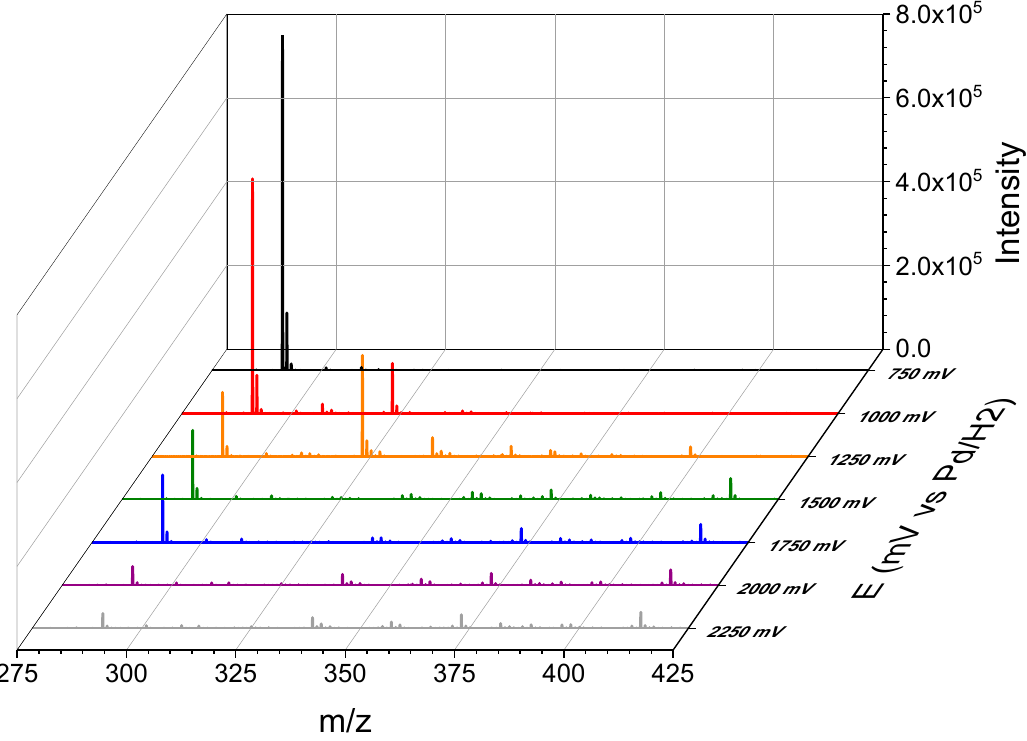
Figure 5. Mass spectrometry voltammogram of TRI obtained with the thin-layer flow cell coupled online with the QqTOFMS. The solution was composed of 0.1% FA in ACN:H 2 O 1:1 and the concentration of TRI ( m / z 291) was 1.25 mg · L − 1 .